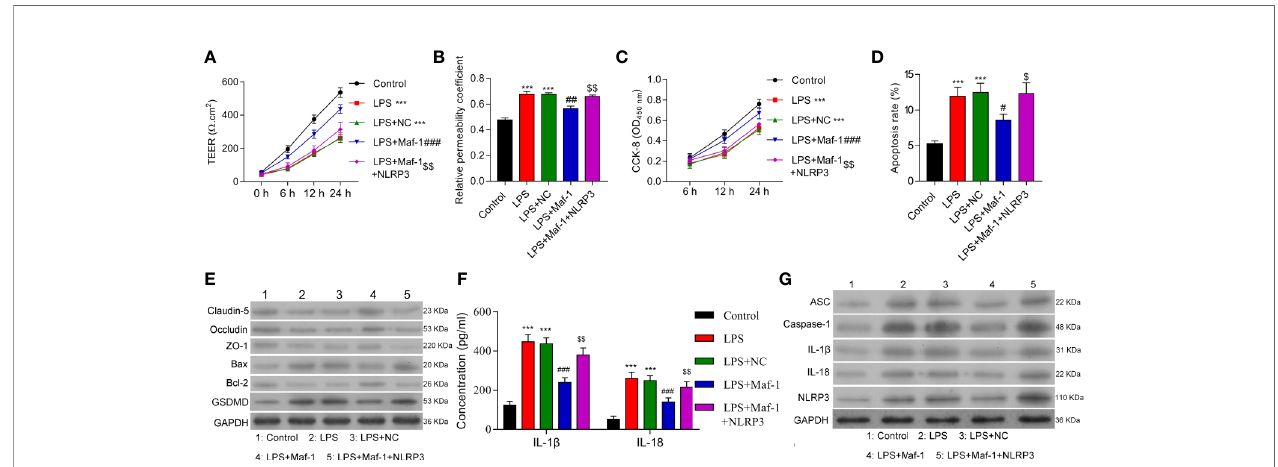
FIGURE 2 | Maf1 suppressed in fl ammation in the LPS-induced in vitro BBB model through inactivation of the NLRP3 in fl ammasome. BMECs were transfected with the control vector (NC), Maf1 or a combination of Maf1and NLRP3, followed by LPS stimulation. The BMECs were then co-cultured with astrocytes to establish an in vitro BBB model. (A) The TEER values of monolayer cells at 0, 6, 12, and 24 h were measured using a bioelectric impedance analyzer. (B) Trans-endothelial permeability assays were performed to assess in vitro BBB integrity by using the diffusion of 10 kDa FITC-dextran method. The relative permeability coef fi cient was determined after the Transwell experiment. (C) Cell viability was analyzed using the CCK-8 assay. (D) Quanti fi cation of cell apoptosis. (E) Western blot results for the levels of Claudin-5, Occludin, ZO-1, Bax, Bcl-2, and GSDMD. (F) The cell-free conditioned culture medium was collected and analyzed IL-1 b and IL-18 levels via ELISA (G) Western blot analyses for pro-in fl ammatory cytokine (ASC, Caspase-1, IL-1 b , and IL-18) and NLRP3 expression levels. Results are expressed as the mean value ± SD of data obtained from three separate experiments. *** p < 0.001, compared with Control; # p < 0.05, ## p < 0.01 and ### p < 0.001, compared with LPS + NC; $ p < 0.05 and $$ p < 0.01 compared with LPS +